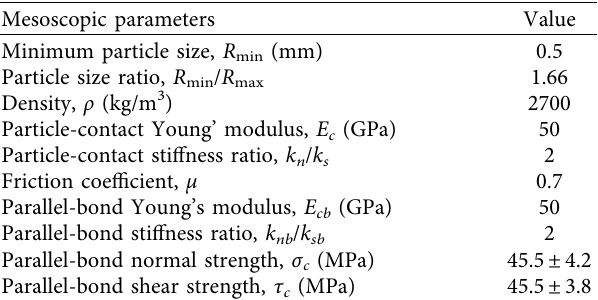
Table 2: Mesoscopic parameters of